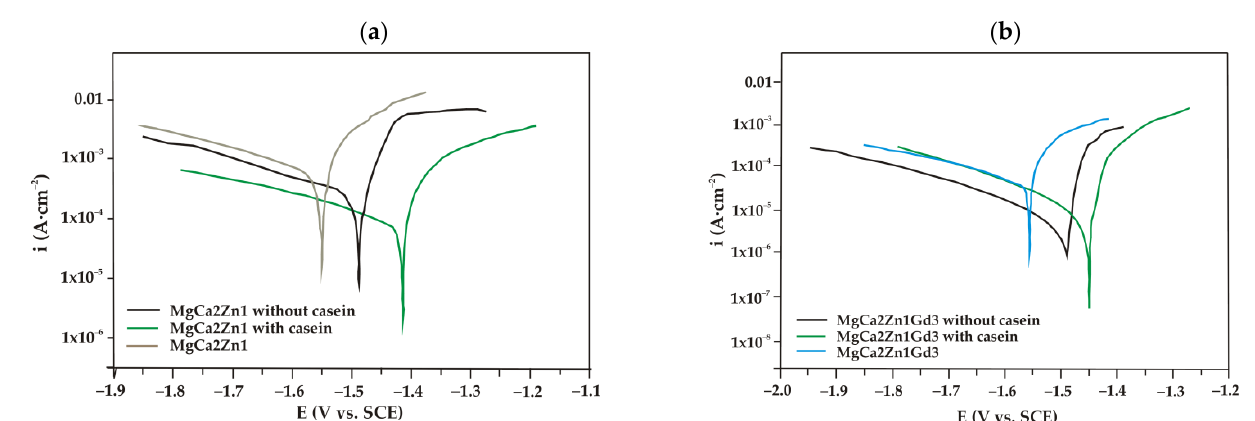
Figure 9. Polarization curves for the casein coating (CN), casein-free coating (NZ), and uncoated Mg-based alloys in Ringer solution at 37 °C, ( a ) MgCa2Zn1 alloy; ( b ) MgCa2Zn1Gd3 alloy.